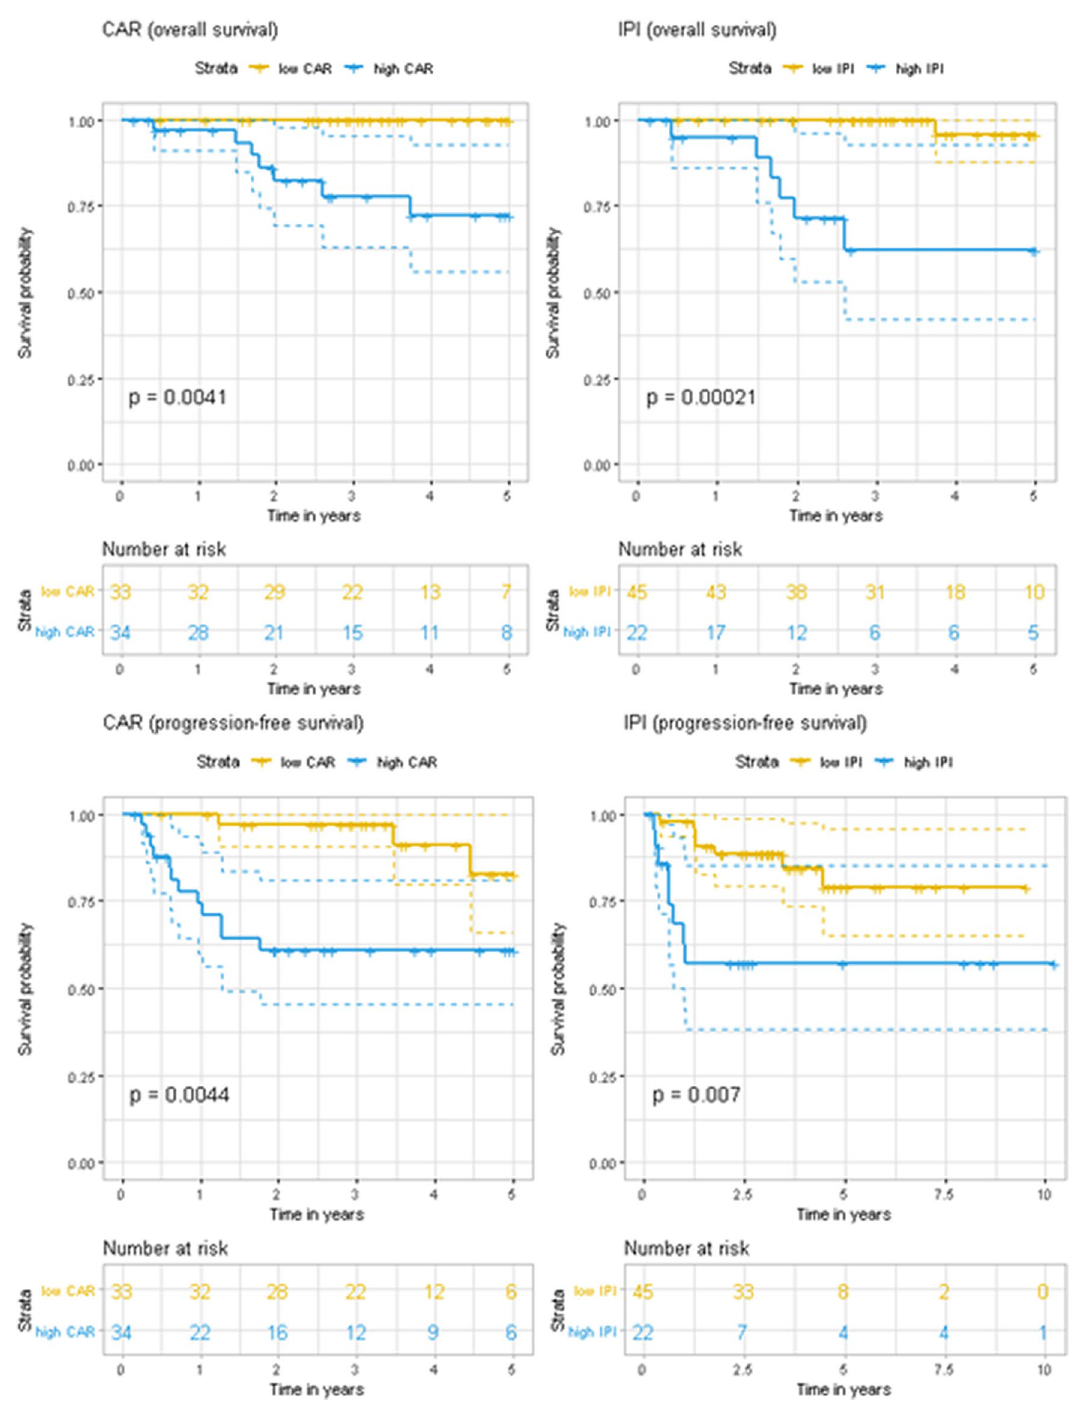
Figure 3. Kaplan–Meier curves for overall survival and progression-free survival according to the C-reactive protein-to-albumin ratio (CAR) and International Prognostic Index (IPI) among patients who were ≤ 60 years old at the diagnosis of diffuse large B-cell